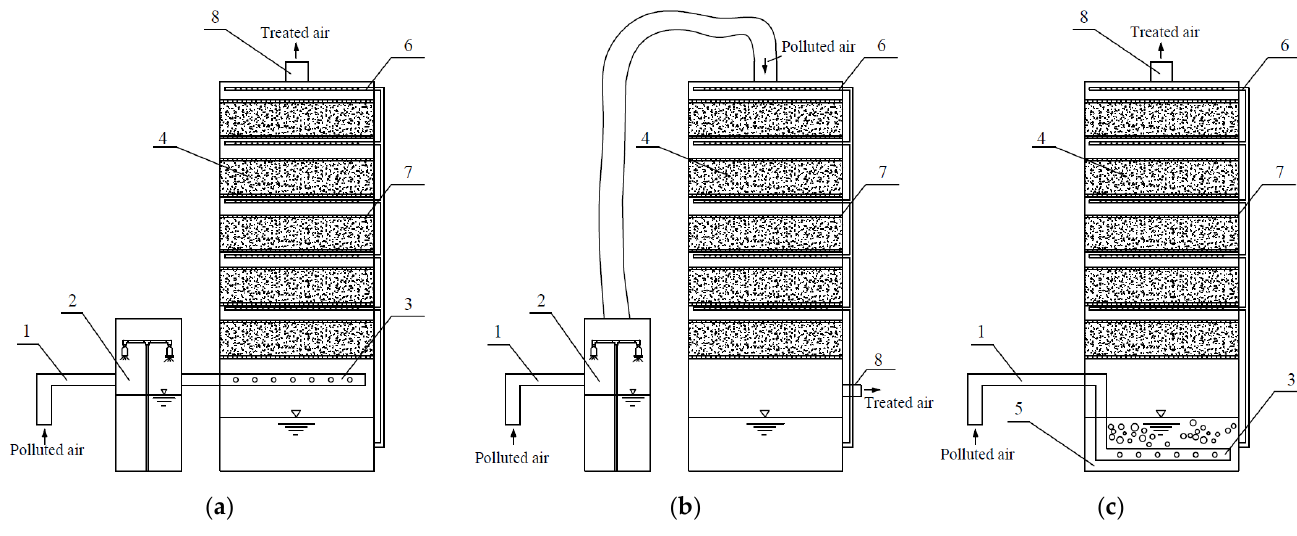
Figure 3. Closed-type biofilters: ( a ) with separate air humidification chamber and ascending gas flow; ( b ) with separate air humidification chamber and descending gas flow; ( c ) with